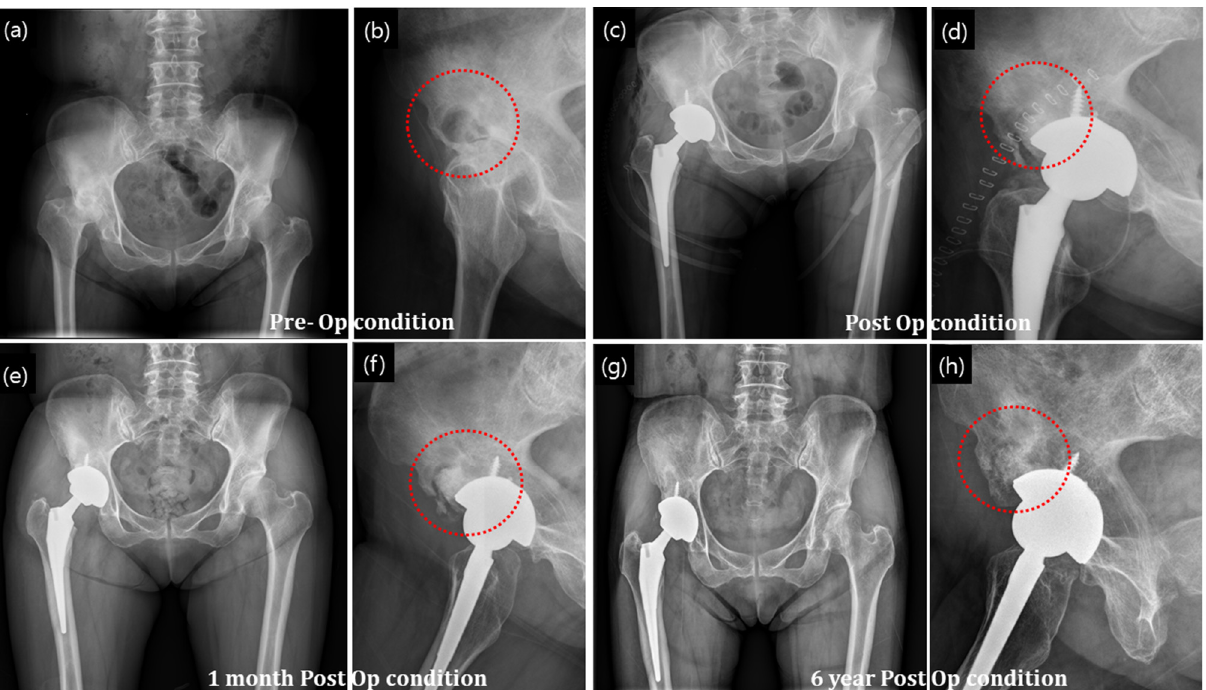
Figure 8. Primary arthroplasty of the hip joint treated with granular bone substitute for restoration of new bone in the necrossed bone ( a , b ) X-ray of the bone with necrosis, ( c , d ) postop condition with application of granular bone substitute around the hip joint implant, ( e , f ) new bone formation at the granular bone graft site after one months of operation and ( g , h ) after 6 years of operation condition. The red circles indicate implanted defect zone.